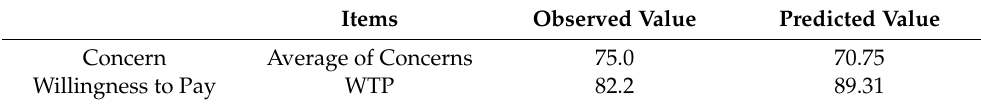
Table 4. Observed value and predicted value for public opinion in South